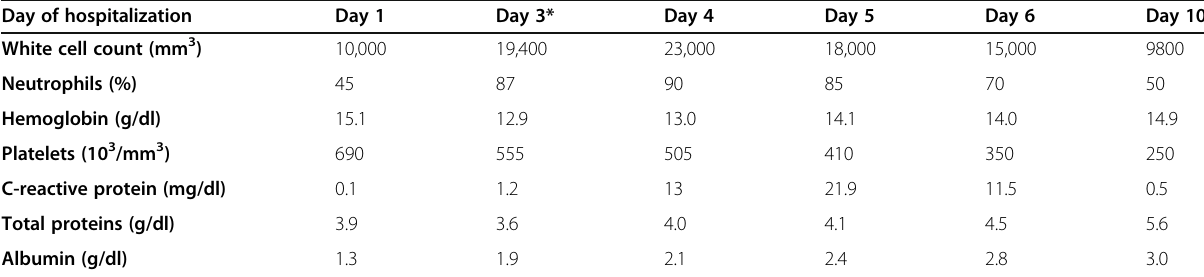
Table 1 Summary of investigations (*beginning of the antibiotic treatment) Day of